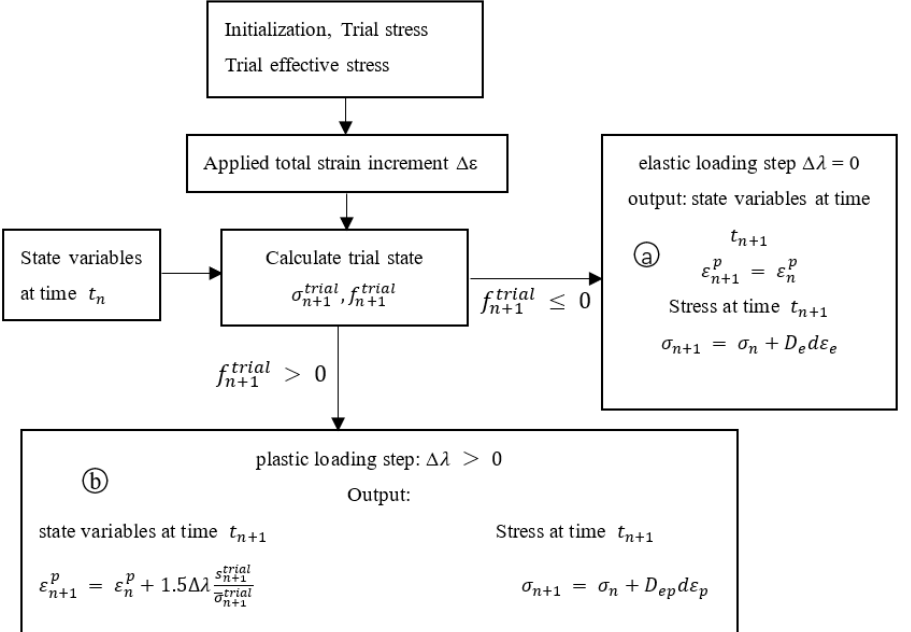
Figure 1. Schematic diagram of subroutine flow.